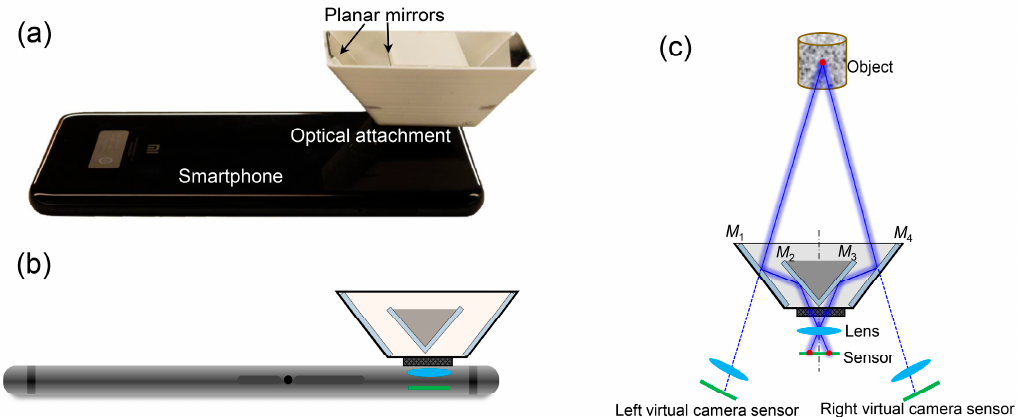
Figure 1. ( a ) Photograph and ( b ) schematic diagram of the established smartphone-based stereo-digital image correlation (DIC) system. ( c ) Schematic diagram of the optical paths of the smartphone-based stereo-DIC system. M 1 , M 2 , M 3 and M 4 represent four planar mirrors installed in the optical attachment.